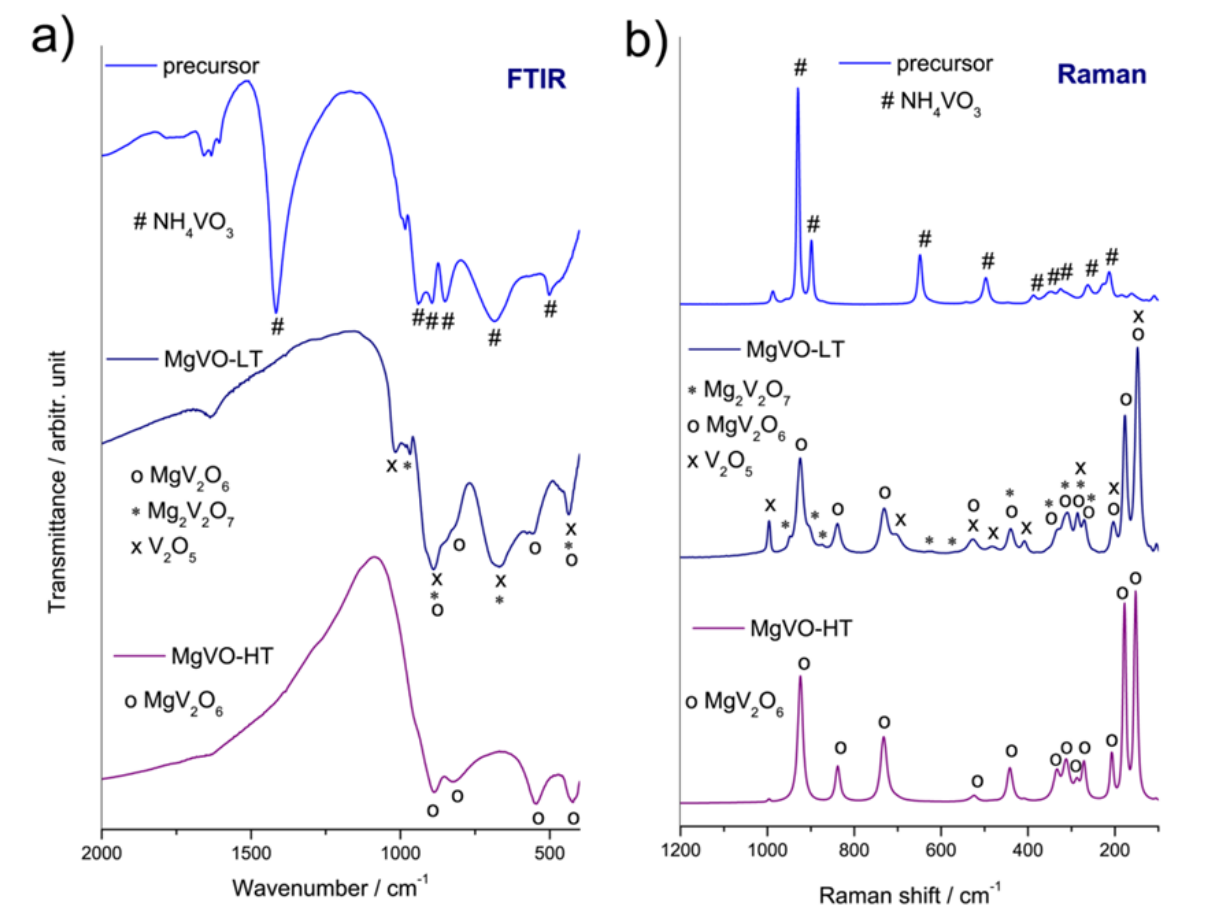
Figure 2. FTIR ( a ) and Raman ( b ) spectra of the MgVO precursor, MgVO-LT, and MgVO-HT material. Table 1. Assignation of the FTIR and Raman spectral bands of the MgVO-HT material.